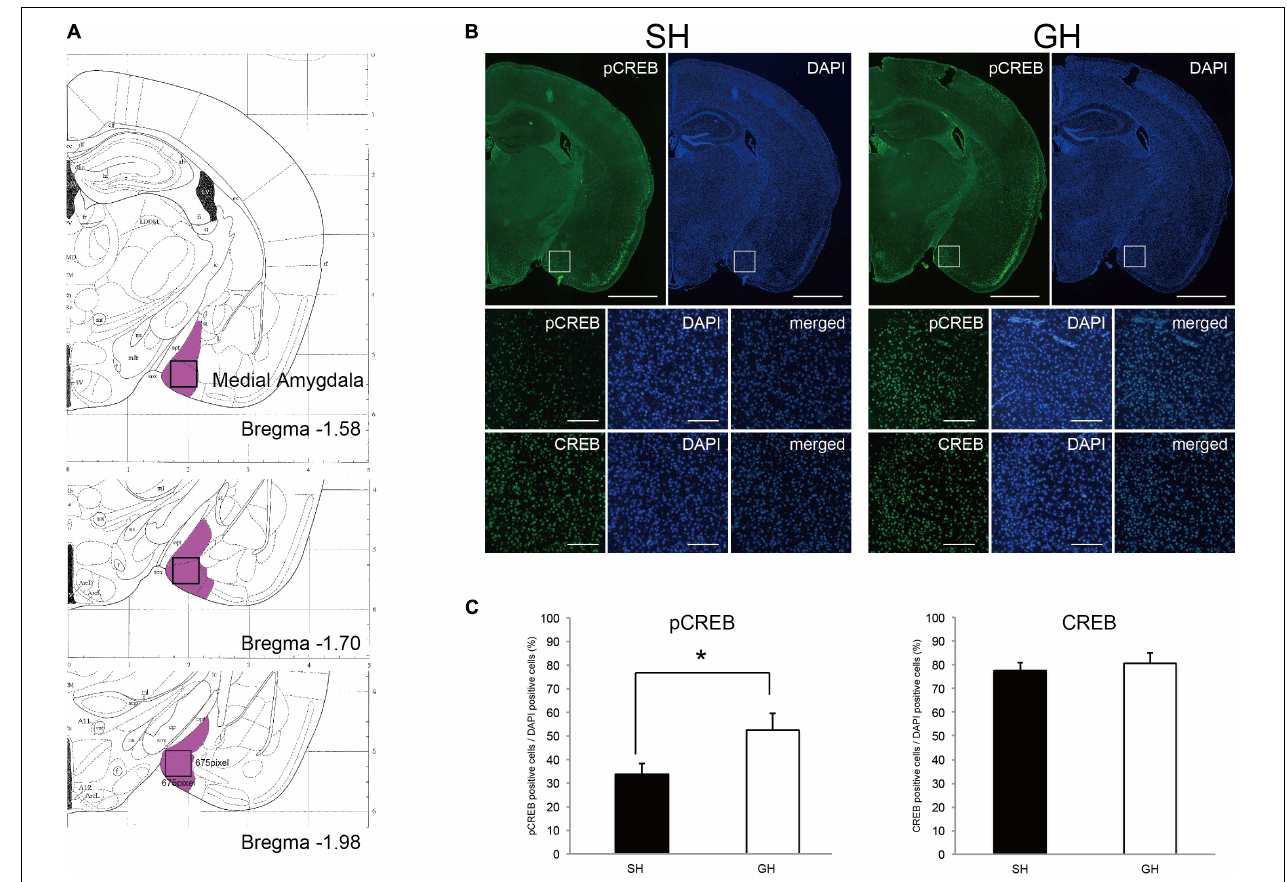
FIGURE 6 | Immunohistochemical detection of cyclicAMP signaling in the medial amygdala of single housing (SH) and group housing (GH) mice. (A) Region of interest (ROI, open box) in the medial amygdala (violet area, ref. Paxinos and Franklin’s the Mouse Brain in Stereotaxic Coordinates). (B) Immunostaining of the coronal sections using anti-phospho cyclic AMP-responsive element-binding protein (pCREB) or anti-CREB antibody. Scales: 500 micrometers for the first-row panels and 50 micrometers for the second and the third row panels. (C) Quantification of anti-pCREB and anti-CREB positive nuclei (mean ± SEM, 4 sections for each mouse, n = 3 or 4). *Significant differences were detected by unpaired t -test ( p < 0.05).